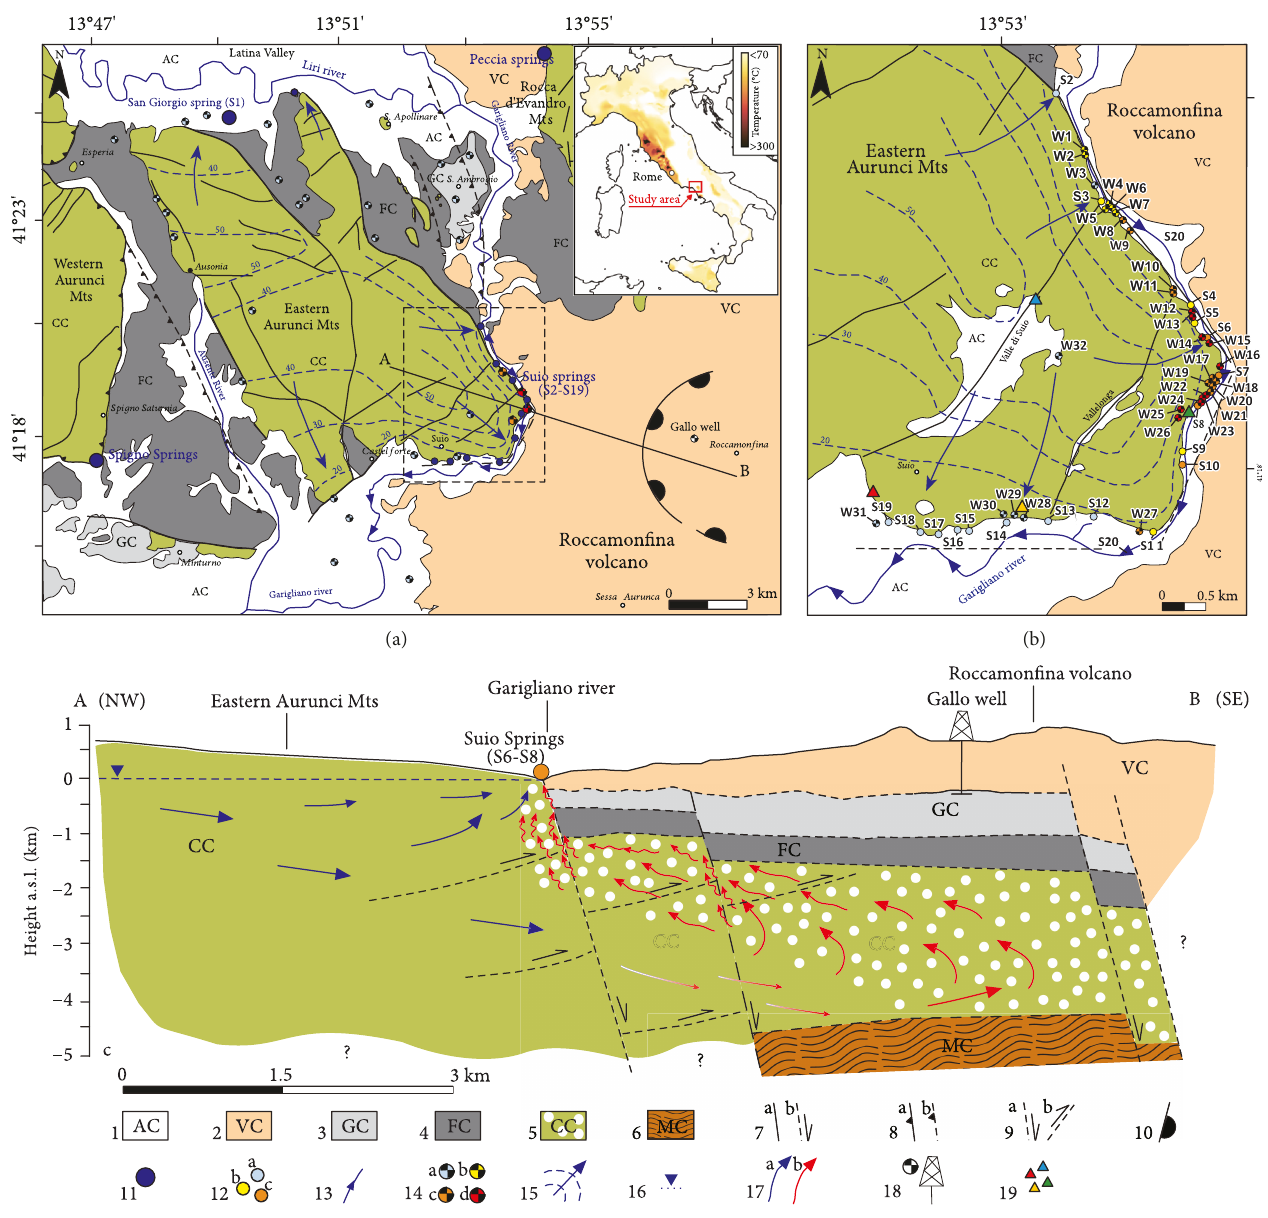
Figure 1: (a) Hydrogeological map of the Eastern Aurunci Mts and Roccamon fi na volcano modi fi ed from [8]. The inset shows the mean temperature at a 3000-meter depth [2]. (b) Detail of the Suio Terme area (the back dashed rectangle in (a)). The numbers refer to the surveyed springs (S) and water wells (W). (c) Geological and hydrogeological section of the Suio area, passing through the A-B cross- section line in (a). Key to the legend: (1) alluvial complex (AC); (2) volcanic complex (VC); (3) sandy-conglomeratic complex (GC); (4) turbidite complex (FC); (5) carbonate complex (CC), the light-blue circles indicate the presence of gas; (6) lower crust or metamorphic rocks (MC); (7) normal faults: (A) certain, (B) inferred; (8) thrust faults: (A) certain, (B) inferred; (9) inferred faults ((c) only): (A) normal and (B) thrust; (10) Caldera nest ((a) only); (11) main springs ((a) only); (12) springs with temperature (A) T < 20 ° C, (B) 20 < T < 35 ° C, (C) T > 35 ° C ((b and c) only); (13) linear springs; (14) water wells with temperature (A) T < 20 ° C, (B) 20 < T < 35 ° C, (C) 35 < T < 50 ° C, (D) T > 50 ° C; (15) groundwater fl ux (blue arrow) and piezometric line (dashed blue curves). The numbers indicate the groundwater elevation in meters a.s.l. (a and b); (16) groundwater table ((c) only); (17) cold (A) and thermal (B) groundwater fl uxes ((c) only); (18) the position of the Gallo well (GW) 85-1 [7] ((a and c) only); and (19) location of the geomechanical stations ((b)